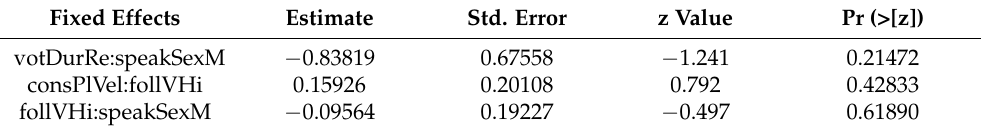
Table A3. Cont. Fixed Effects